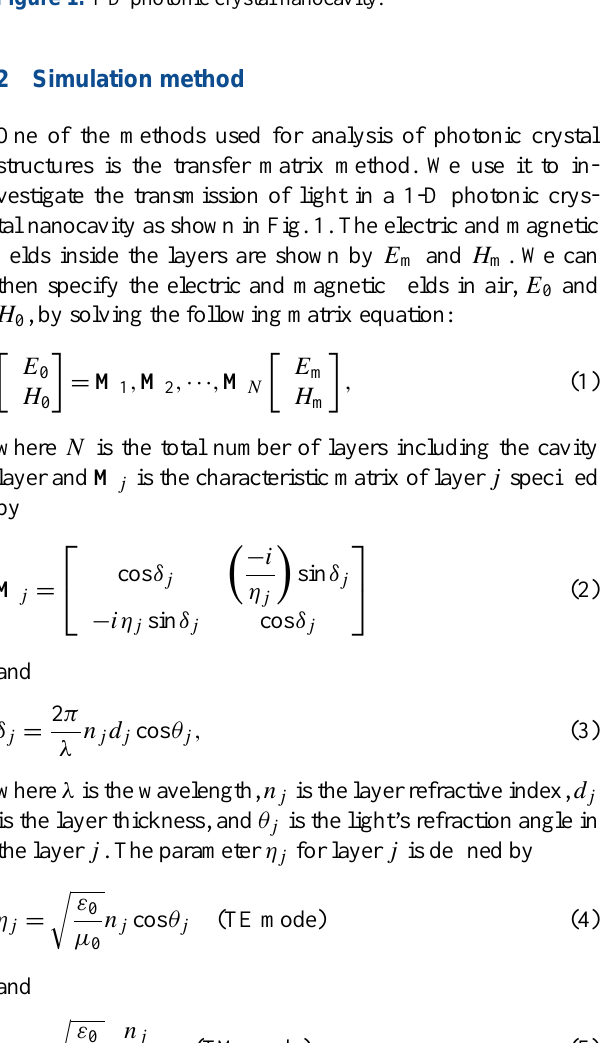
Figure 1. 1-D photonic crystal nanocavity.